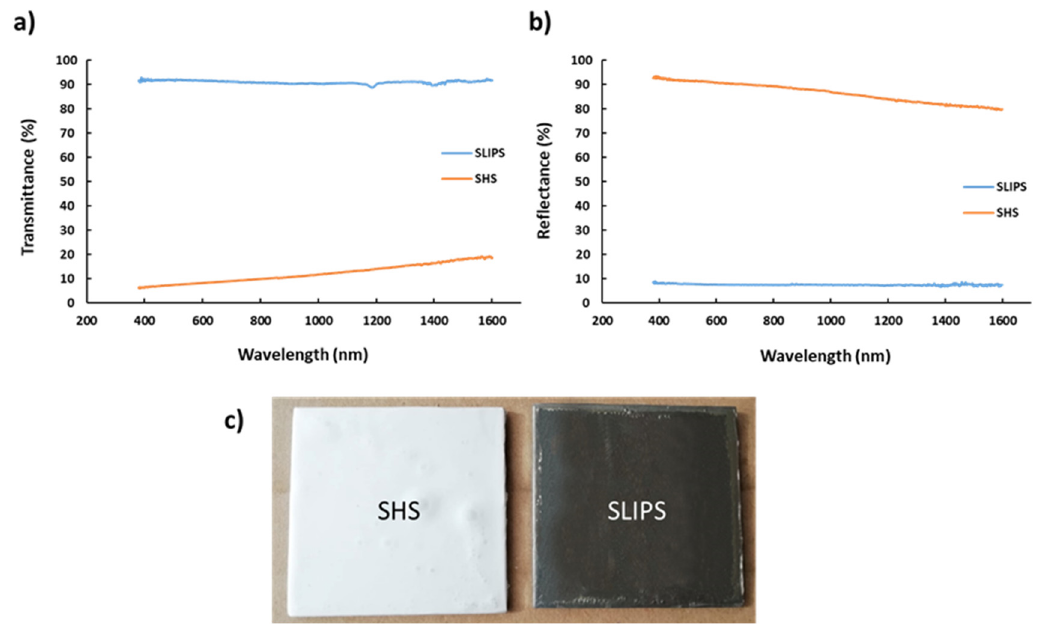
Figure 21. ( a ) Transmittance Vis-NIR spectra of the SHS and SLIPS samples. ( b ) Reflectance Vis-NIR spectra of the SHS and SLIPS samples. ( c ) The resultant SHS and SLIPS appearance.